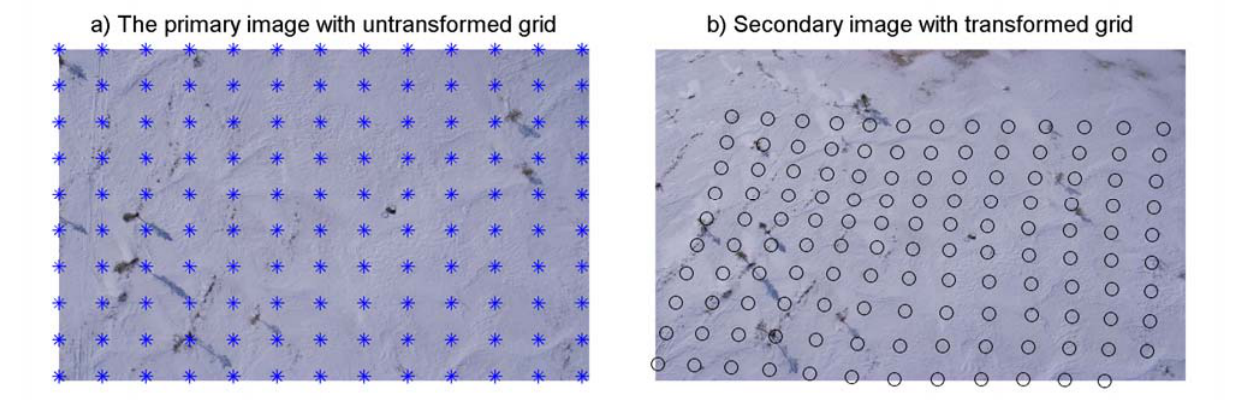
Figure 5. Two images from the dataset with the grid-square corner points overlaid on top. ( a ) The primary image with the untransformed grid of 300 × 300 pixel squares. ( b ) Another image from the dataset with the transformed grid from the primary